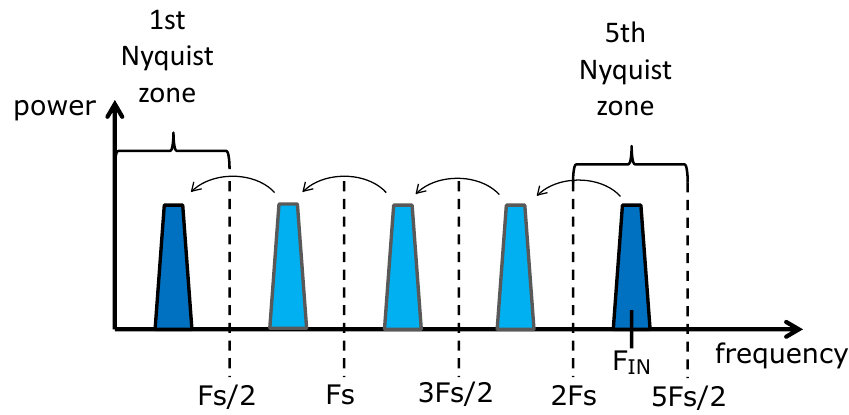
Figure 3. Direct sampling of an RF signal with aliasing to the 1st Nyquist